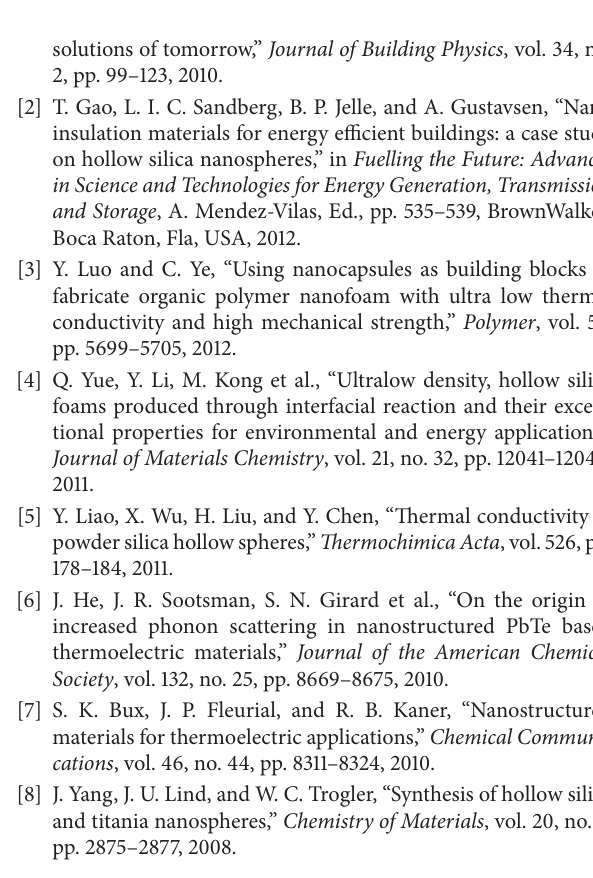
conductivity values for all four samples within an uncertainty of two times the standard deviation of the mean, that is, with a confidence interval of